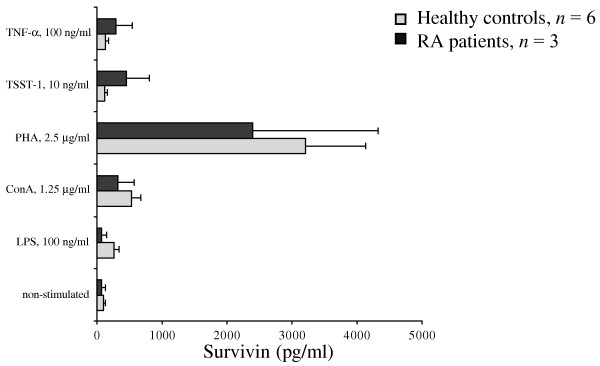
Expression of survivin in lysates from peripheral blood mononuclear cells of rheumatoid arthritis (RA) patients and from healthy controls following stimulation with various mitogens. Survivin expression was measured following 48 hours of stimulation. TNF-α, tumour necrosis factor alpha; PHA, phytohaemagglutinine; ConA, Concanavalin A; LPS, lipopolysaccharide.